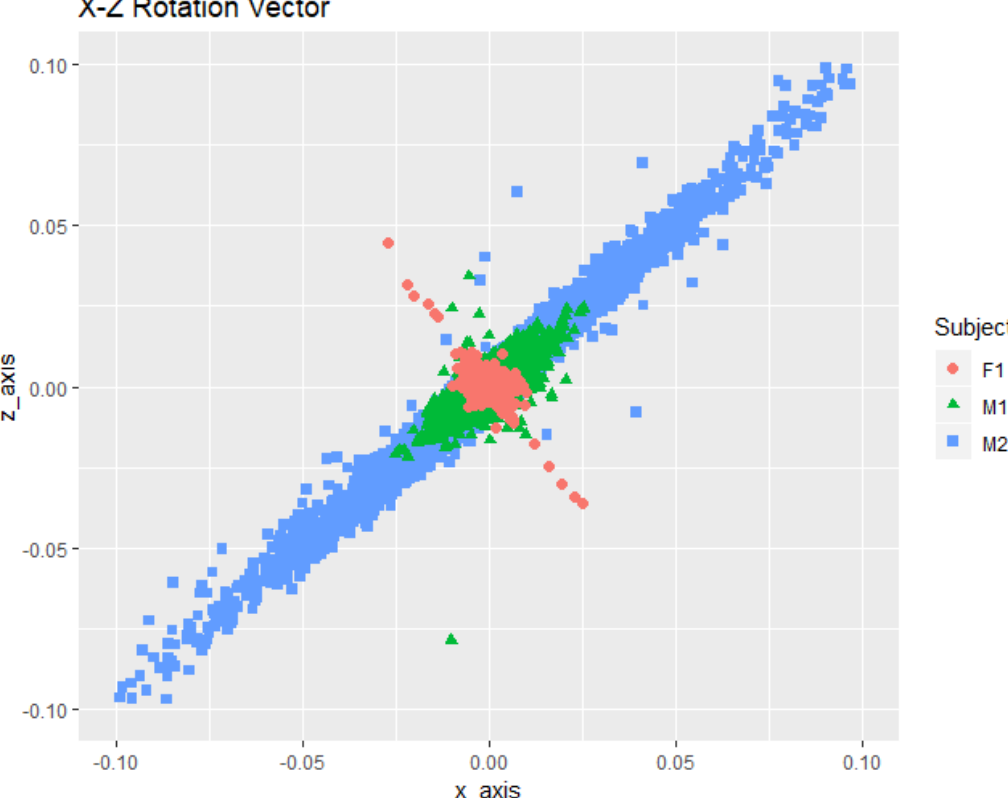
Figure 10. X-Z rotation vector. F1: healthy female; M1: healthy male; M2: male with back